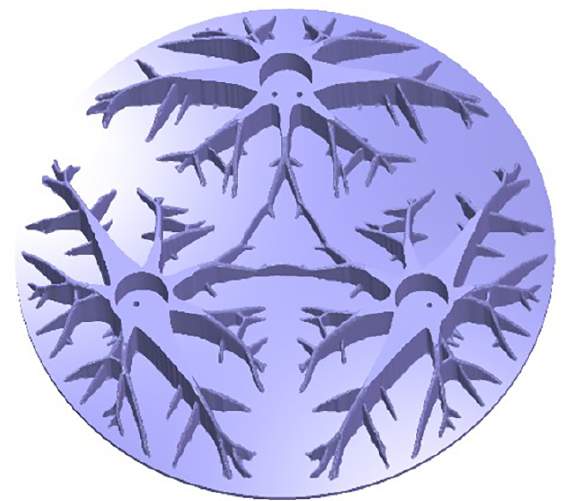
Figure 7. Configuration of mirror topology-optimization scheme. Apply a self-weight load to the mirror under the state of processing, assembly, and alignment (optical axis horizontal), and the deformation caused by gravity was accurately analyzed by the finite-element method; the mirror-displacement data were obtained, and the deformed surface was fitted with the standard Zernike polynomial to remove the effects of rigid body deflection and defocusing error. Then, the corresponding surface-shape error was calculated. The RMS value was 9.7 nm considering the processing residual (which is usually better than 25 nm RMS); the surface-shape error met the requirement better than λ /20 ( λ = 632 nm); and the normal displacement clouds of the mirrors are shown in Figure 8.